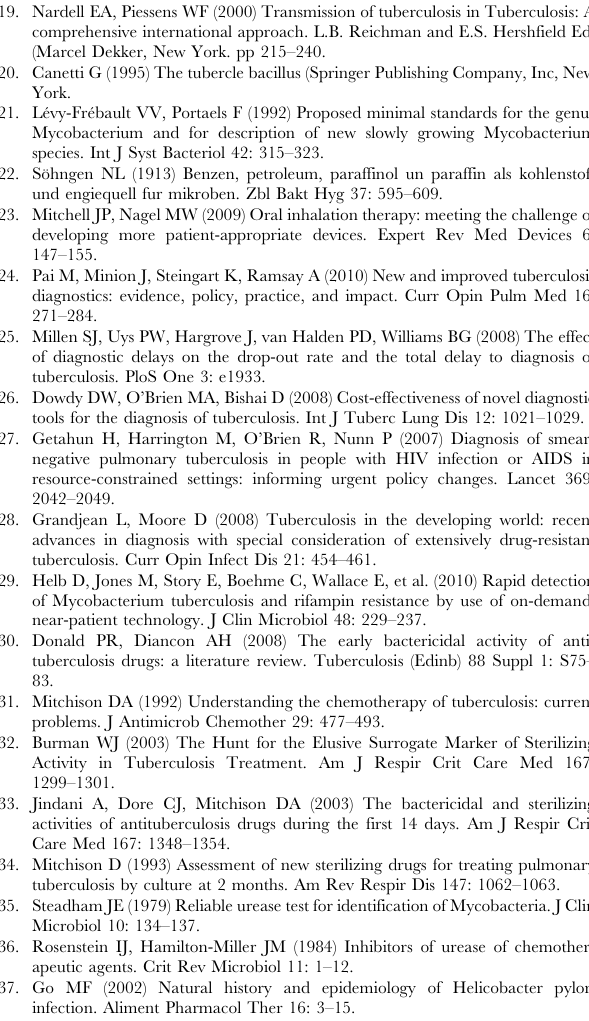
and plating dilutions. M. bovis infected rabbits had displayed the greatest intrapulmonary and extrapulmonary pathology. Figure S1 Urease activity of select Mycobacterium species. (A) Differentiation of observed urease activity was undertaken of M. bovis BCG, M. tb. CDC 1551, and two urease deficient mutants ( M. tb. CDC 1551 D ureB and D ureD ), Colorimetric changes were visually observed after one and three days post inoculation with a urea-embedded disc. (B) Optical density measurements were undertaken after 3 days of incubation with the urea discs and specificity of urease activity was normalized to CFU counts. Figure S2 Mean pulmonary CFU counts at necropsy for evaluable M. bovis -infected rabbits. Multiple samples of the right (the site of infection) and left (contralateral) lung tissue were removed from areas with the greatest discernable gross pathology. Samples from the cavity wall and luminal caseous contents material were also obtained. The log CFU count/gram of tissue was determined after tissue homogenization and plating dilutions. The graph displays solely evaluable rabbits with detectable CFUs in all lung tissues. Additional information is in Table S1.